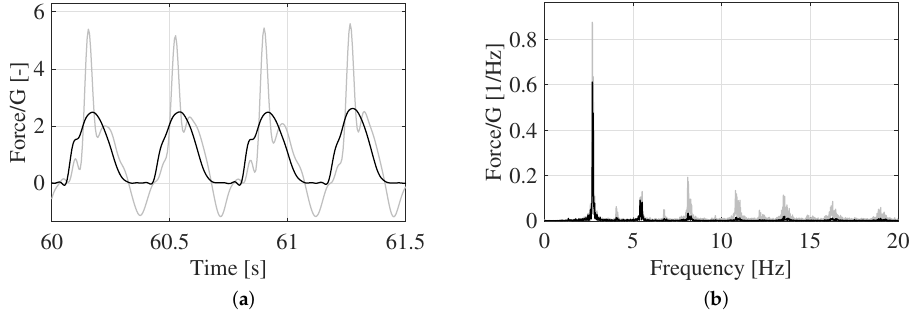
Figure 4. The load induced by participant 1 during test 1, measured forces (black), reconstructed using Newton’s second law (gray): ( a ) time series, ( b ) amplitude